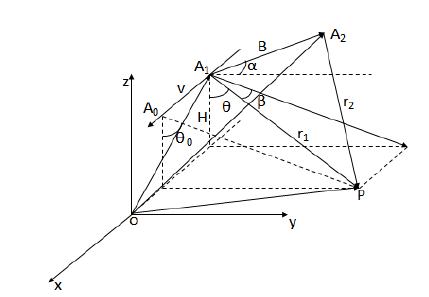
Figure1. Two different coordinates and location